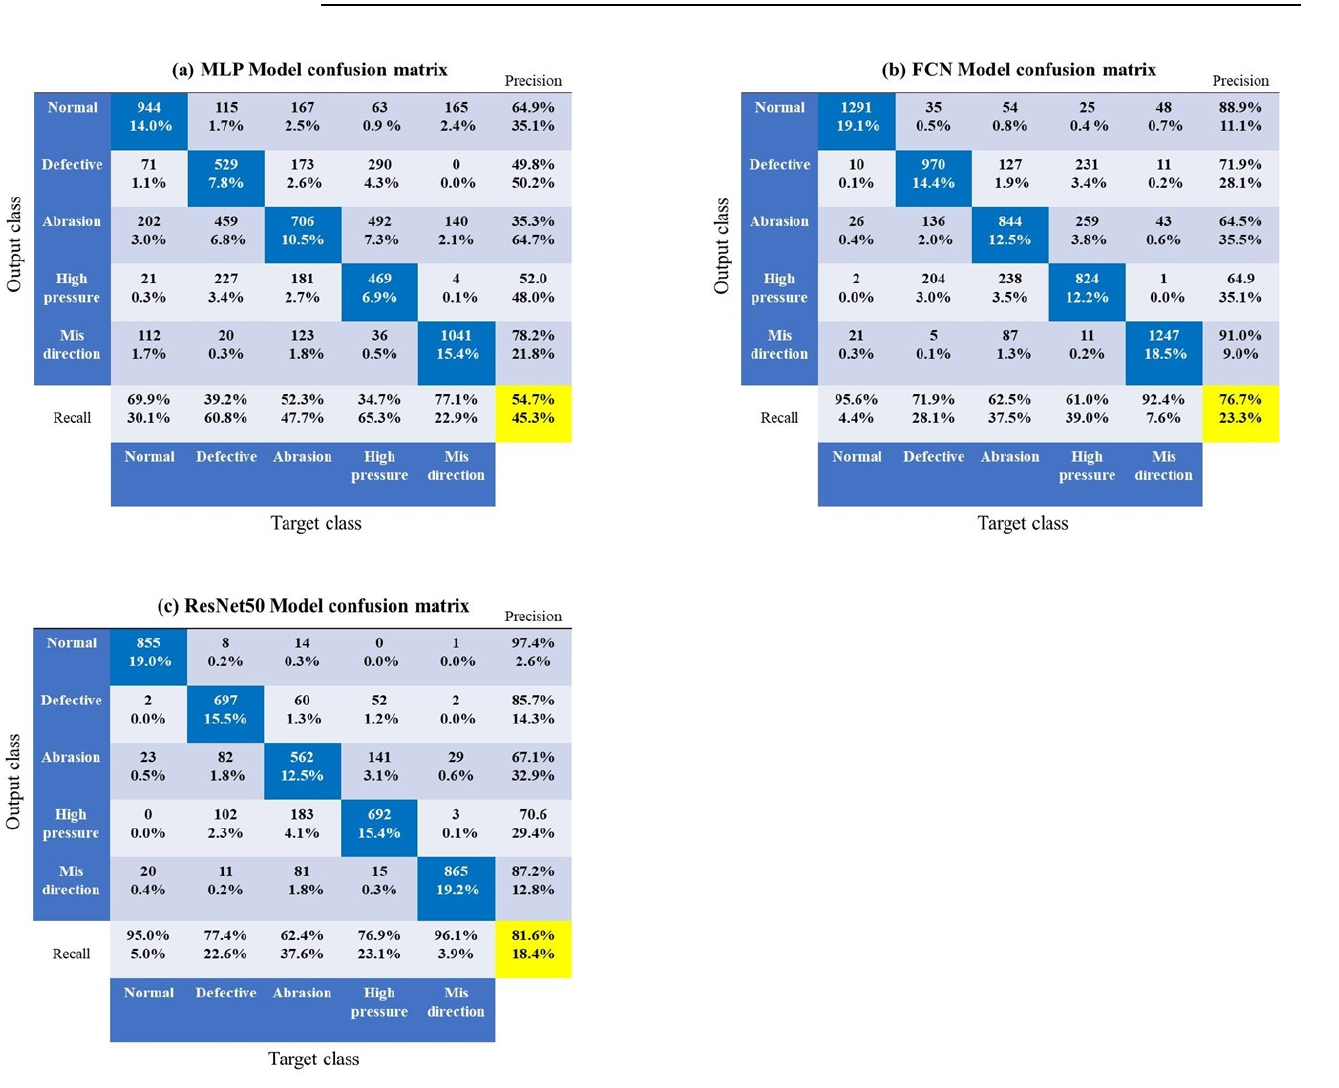
Figure 12. Confusion matrix showing the classification results from the three SOTA models; ( a ) MLP model’s confusion matrix, ( b ) FCN model’s confusion matrix, ( c ) ResNet50 model’s confusion matrix.